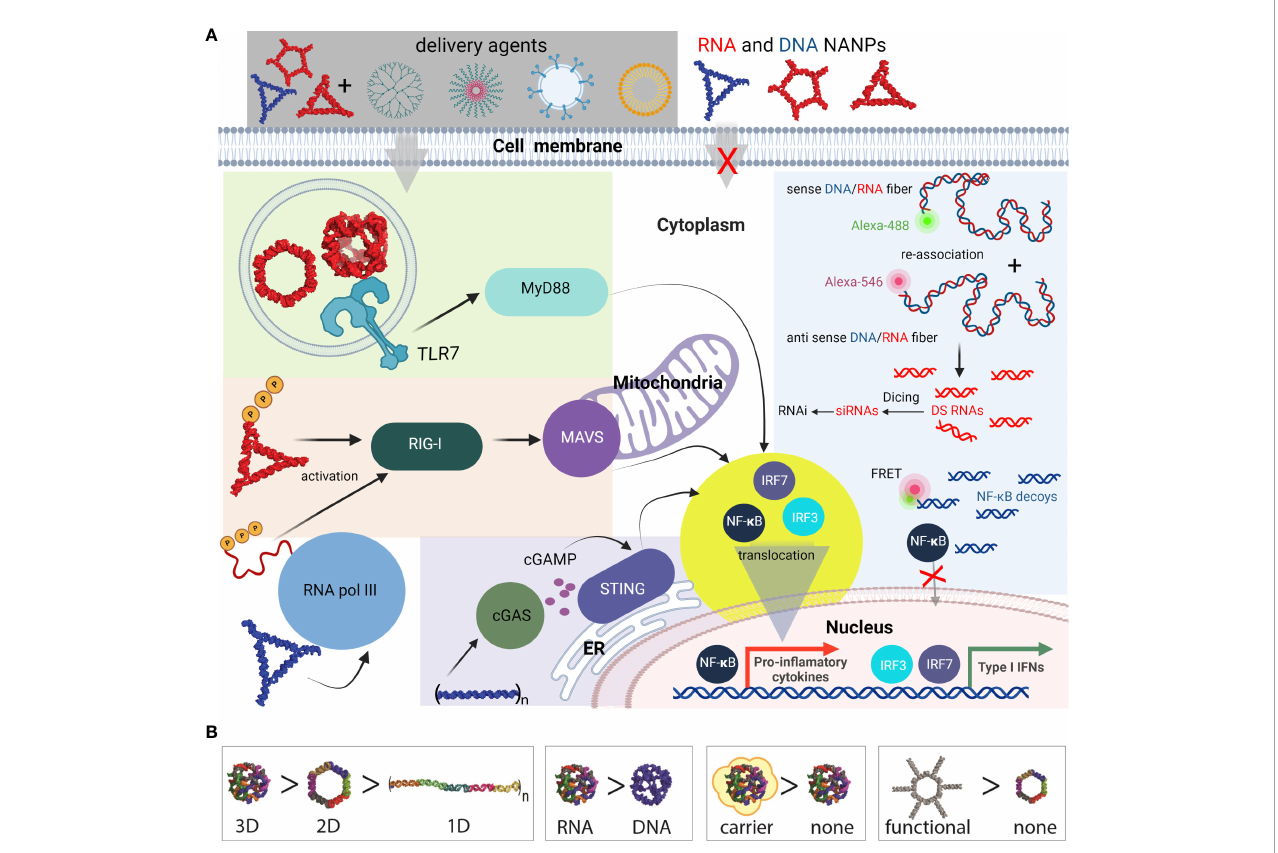
FIGURE 6 Most common innate pathways shown to be activated upon NANPs internalization. (A) Intracellular delivery of NANPs requires carriers; naked NANPs are immunoquiescent due to their ineffective crossing of biological membranes. Delivery of RNA rings and cubes trigger the immune system through TLR7. By-passing of TLR sensing can be compensated by RIG-I that can detect RNA NANPs bearing 5 ’ triphosphates. DNA containing NANPs can be sensed after promoter independent transcription of NANPs strands by RNA pol III. DNA fi bers stimulate cellular immunity through cGAS-cGAMP-STING pathway. Additionally, interdependent DNA/RNA fi ber NANPs can be rationally designed to release of RNAi inducers and NF- k B decoys upon their intracellular re- association. This results in gene speci fi c silencing while simultaneously blocking NF-kB translocation to nucleus thus lowering the proin fl